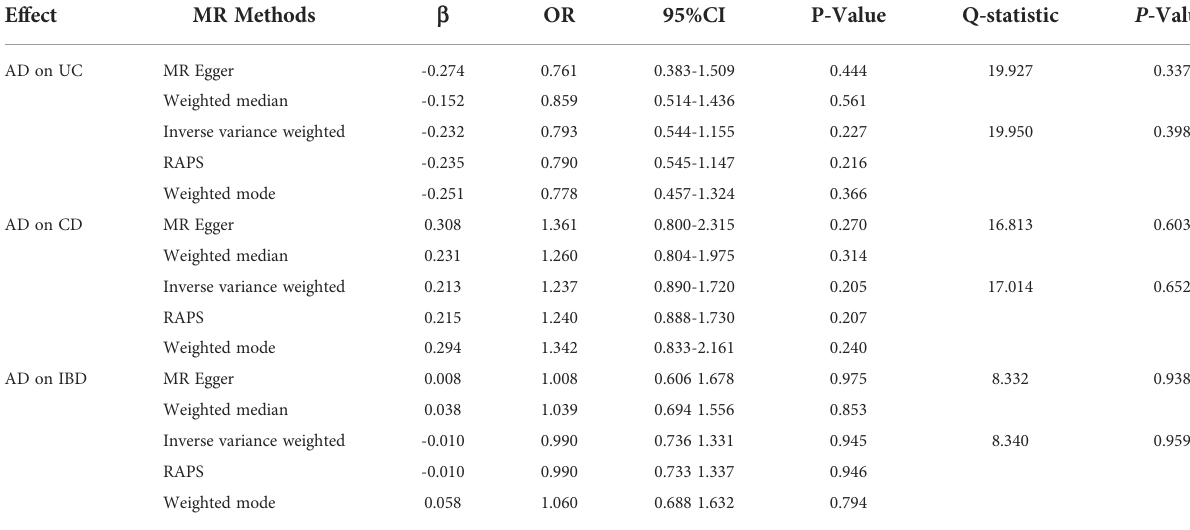
TABLE 2 Mendelian randomization estimates for causal effects of AD on